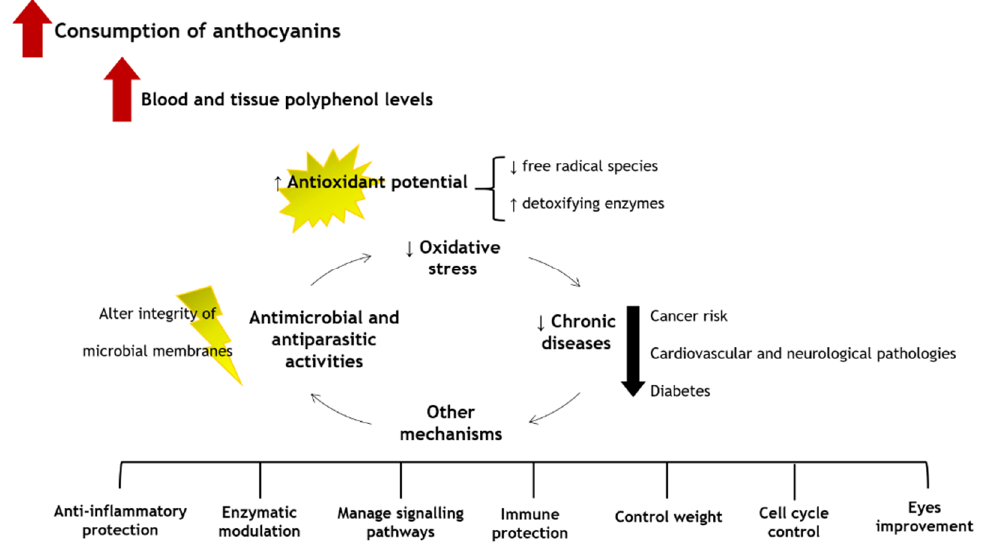
Figure 5. Health benefits of anthocyanins.